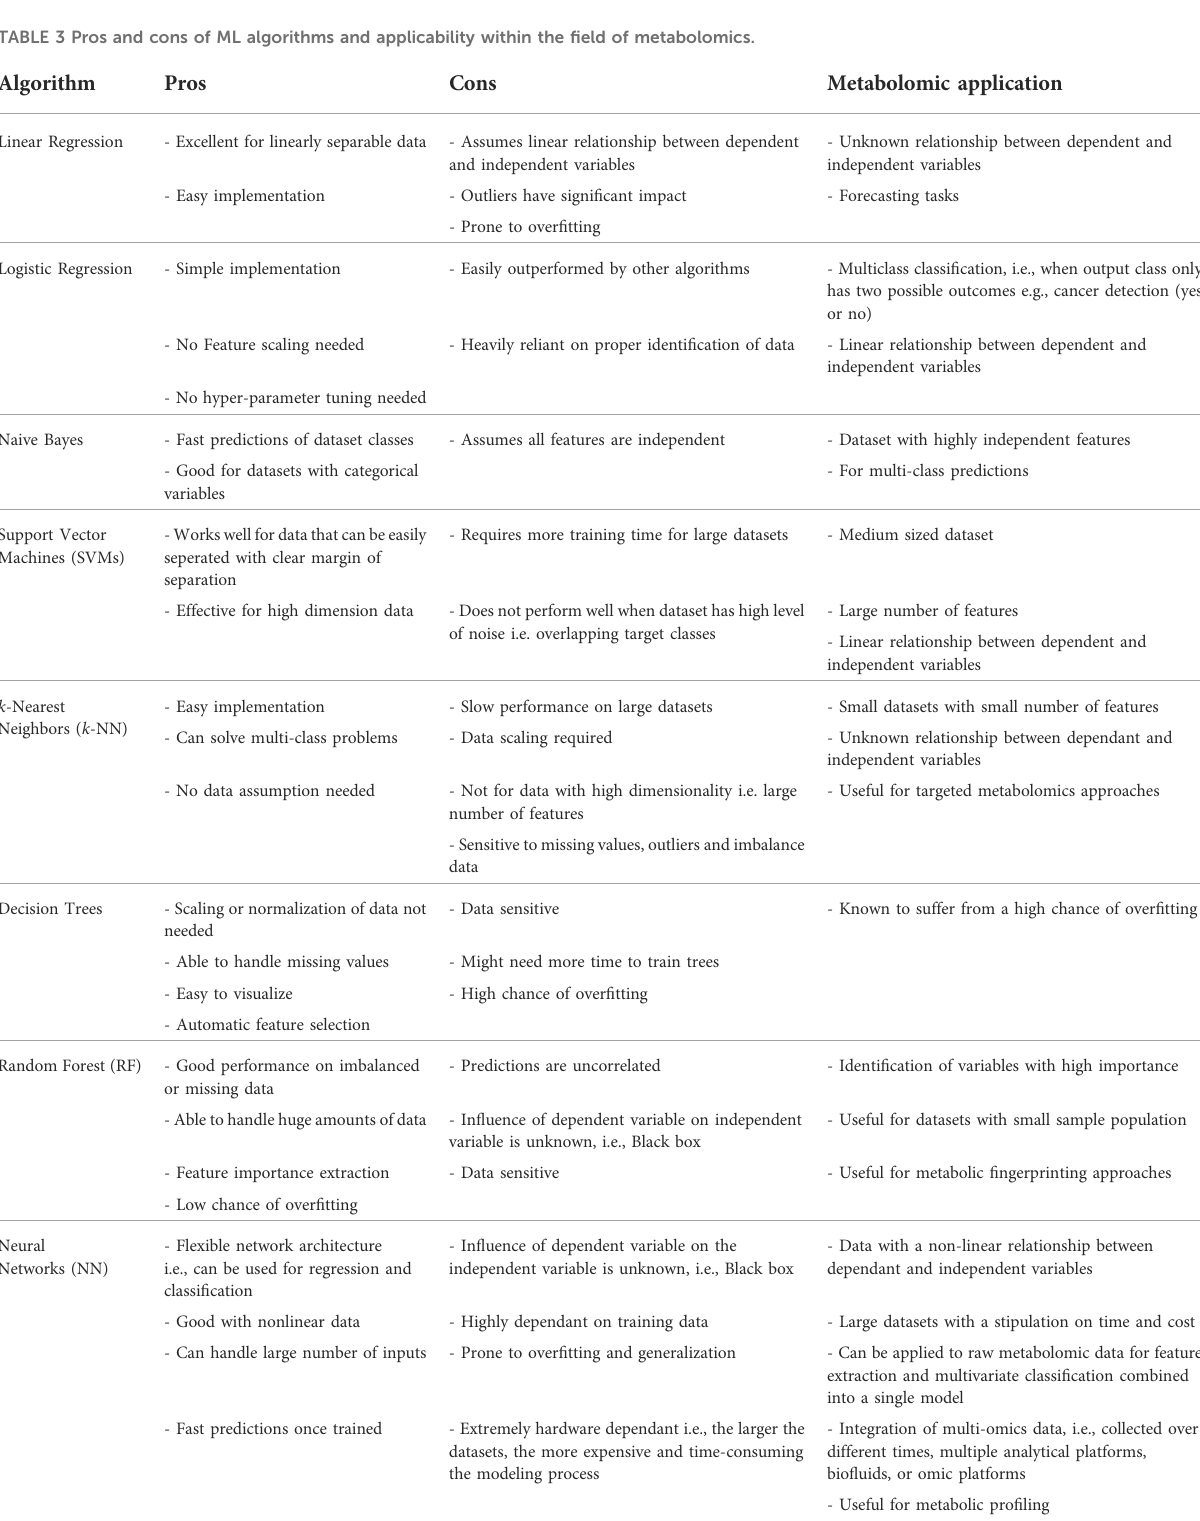
TABLE 3 Pros and cons of ML algorithms and applicability within the fi eld of metabolomics. Algorithm Pros Cons Metabolomic application Linear